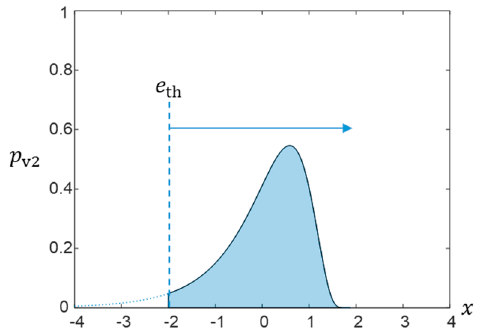
Figure 7. Cut-off for the PDF of GNDv2.